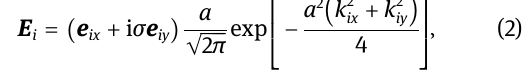
Figure 2: Schematic diagram of geometric phase [6]. Reproduced with permission. Copyright 2015, Macmillan Publishers Limited, part of Springer